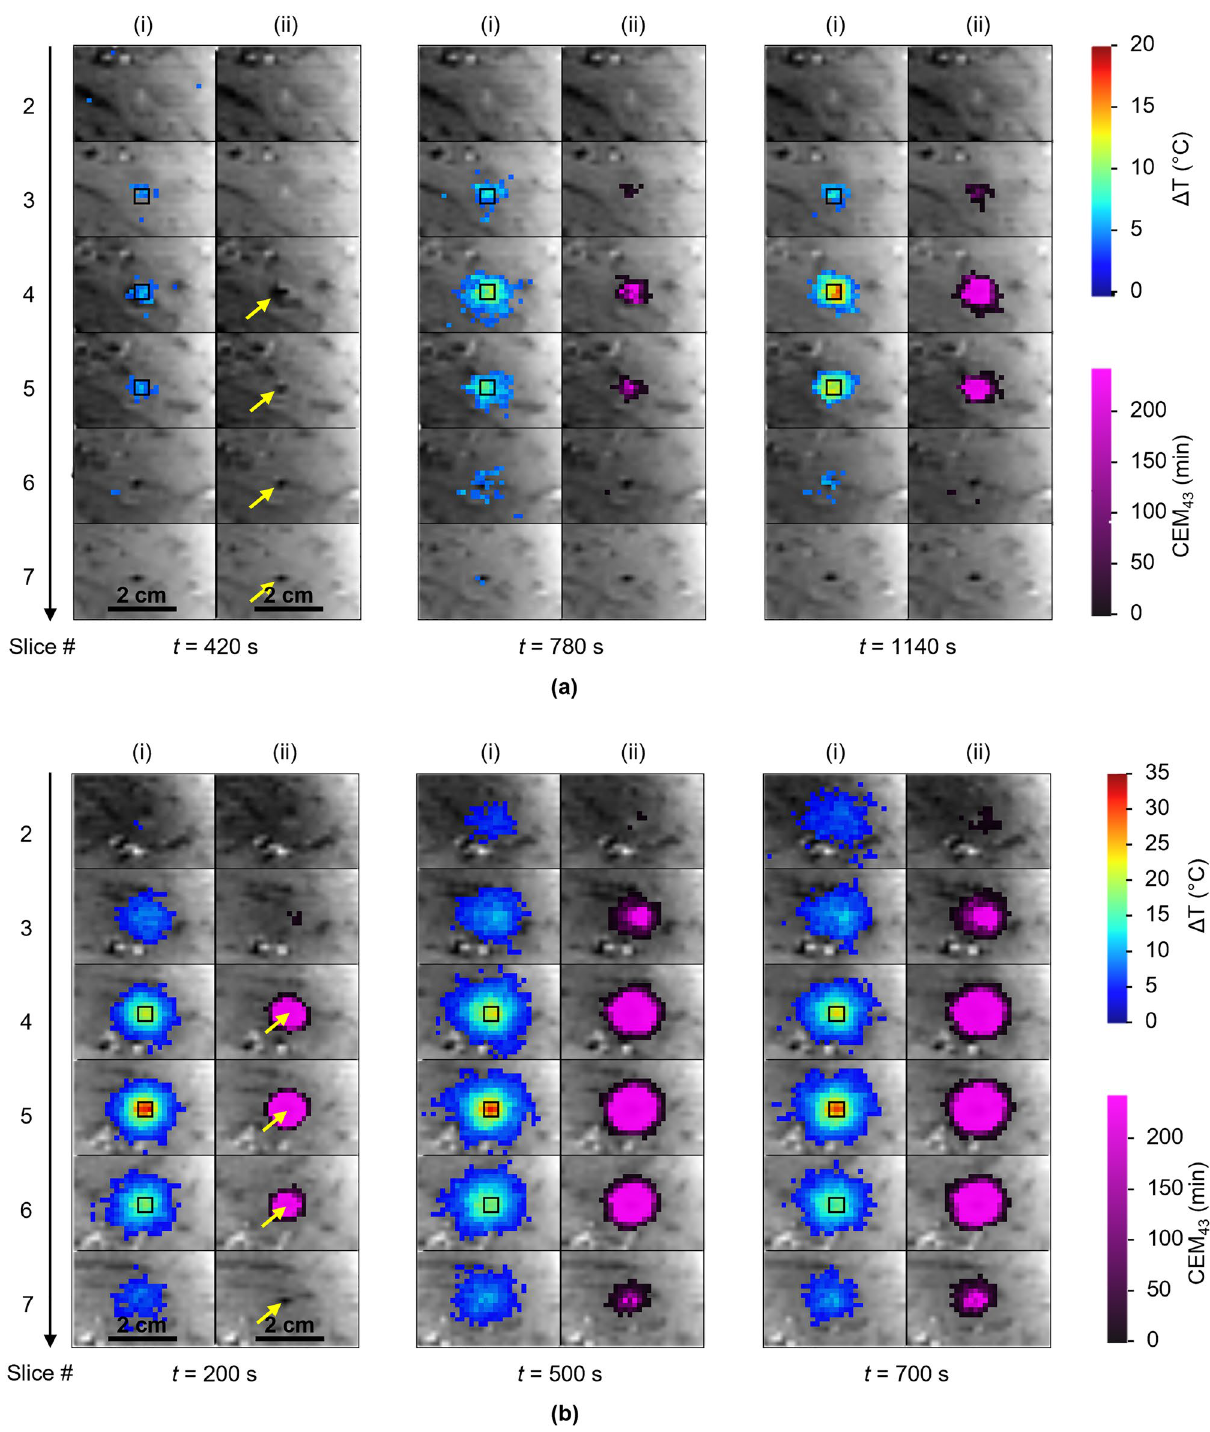
Figure 6. Temperature (i) and thermal dose (ii) images for the example of automatic temperature regulations during LITT in a pig leg muscle, for 2 temperature–time profiles showing 3 successive plateaus (5 °C, 10 °C, and 15 °C—300 s duration each) ( a ) and one unique plateau of 30 °C for 700 s ( b ) at different times t a = [420, 780, 1140] s et t b = [200, 500, 700] s, respectively. Yellow arrows show the laser probe on the magnitude images and black squares represent the ROI used for the automatic